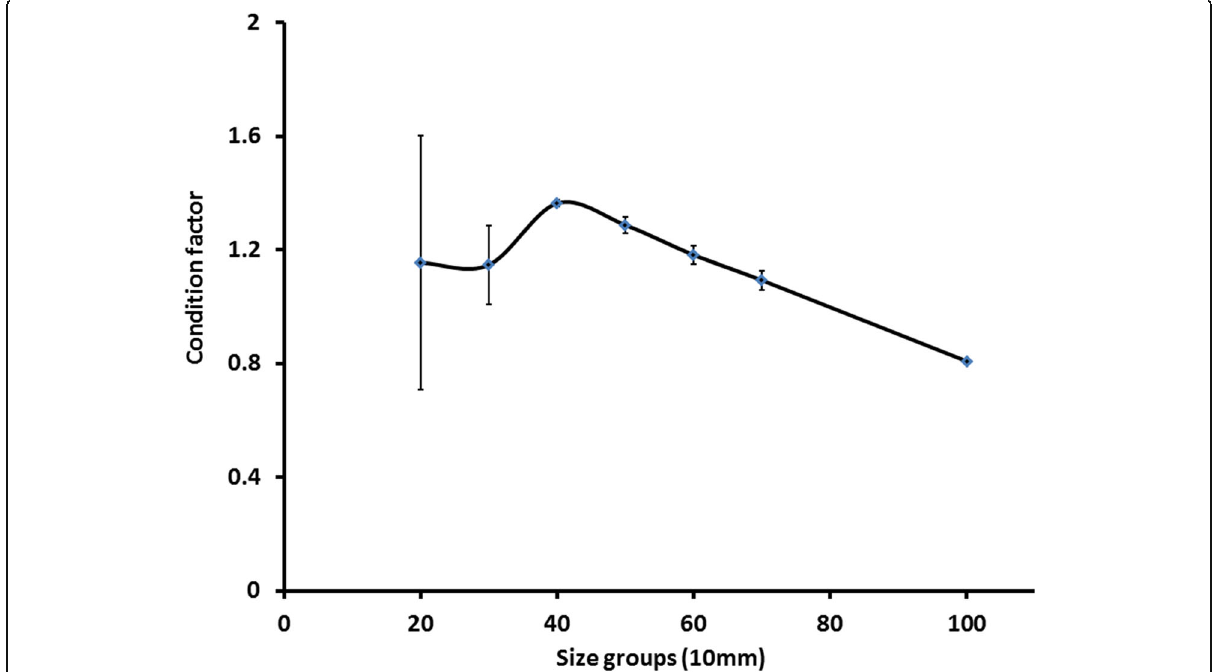
Fig. 4 Relationship between condition factors with different size groups of Pila globosa